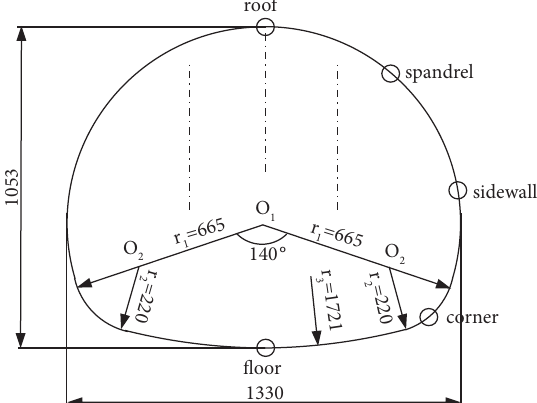
Figure 3: Railway tunnel for a two-lane high-speed passenger line with speeds of 300km/h and 350km/h (unit: mm).